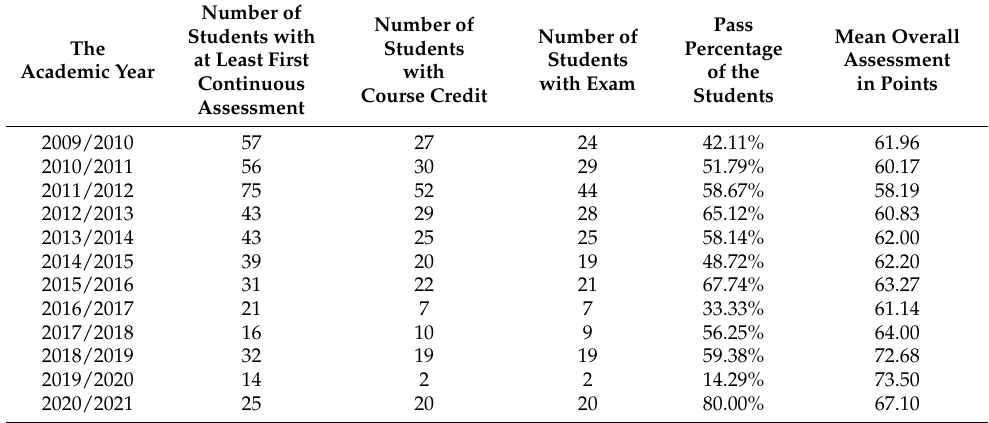
Table 1. Evolution of the number of students and their success rate in the Mathematics course.